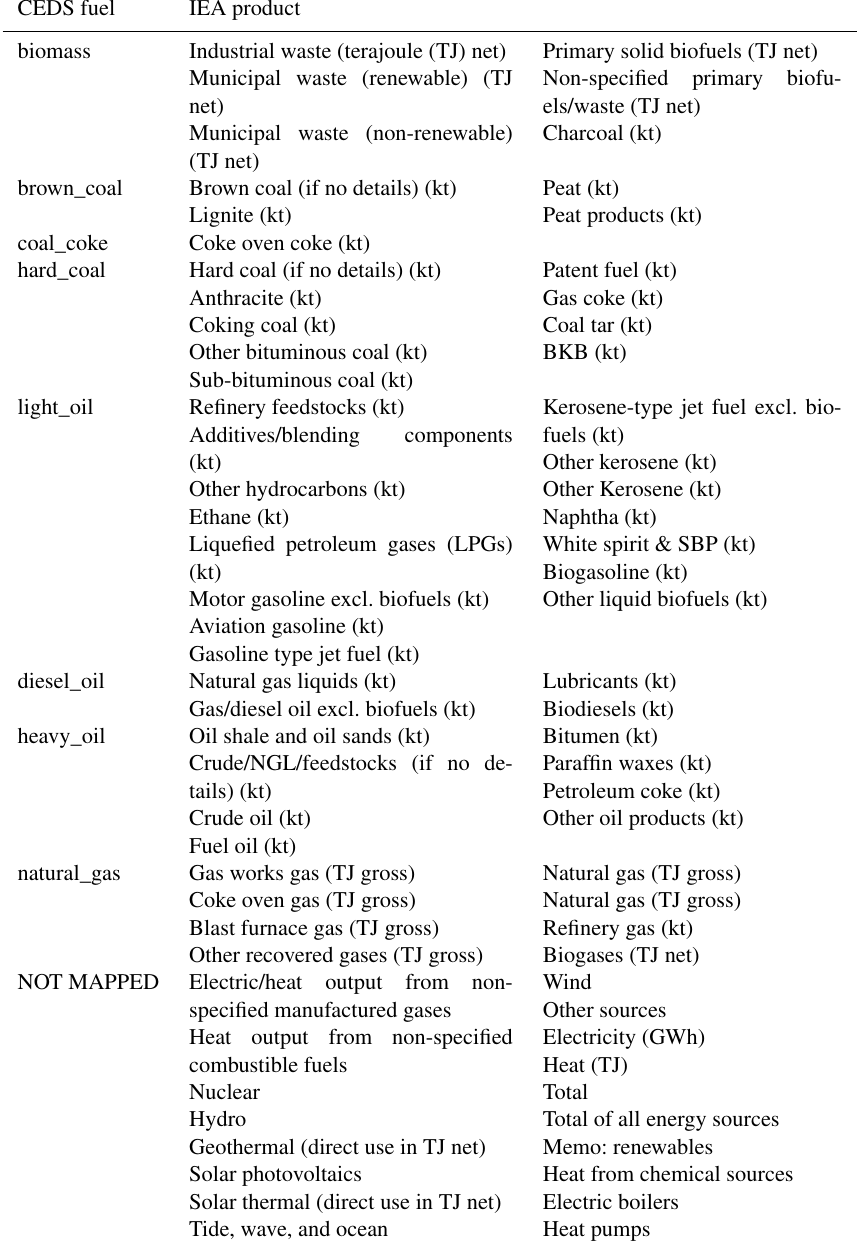
Table A3. Fuel mapping to IEA